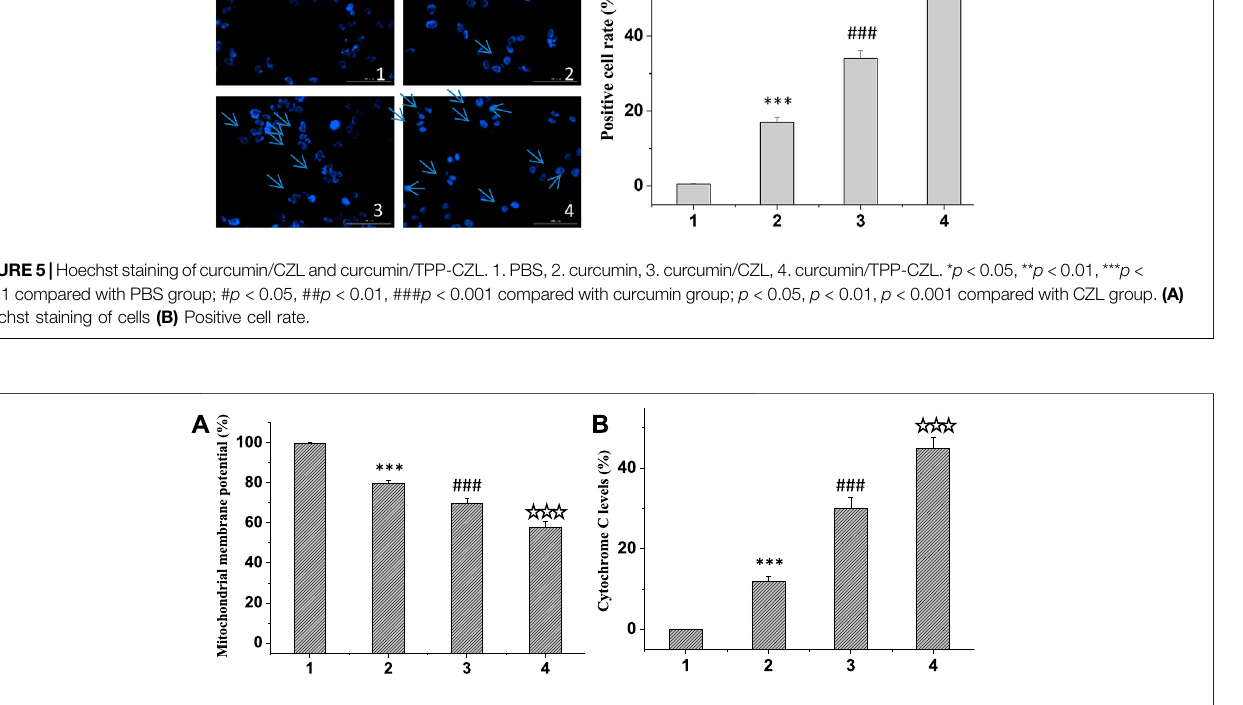
Figure 4 illustrated that some green fl uorescent emitted from nanomicelles coincide with the red fl uorescent of mitochondria. After the coincidence, the color of the fl uorescent became yellow, which has a good time correlation. With the extension of